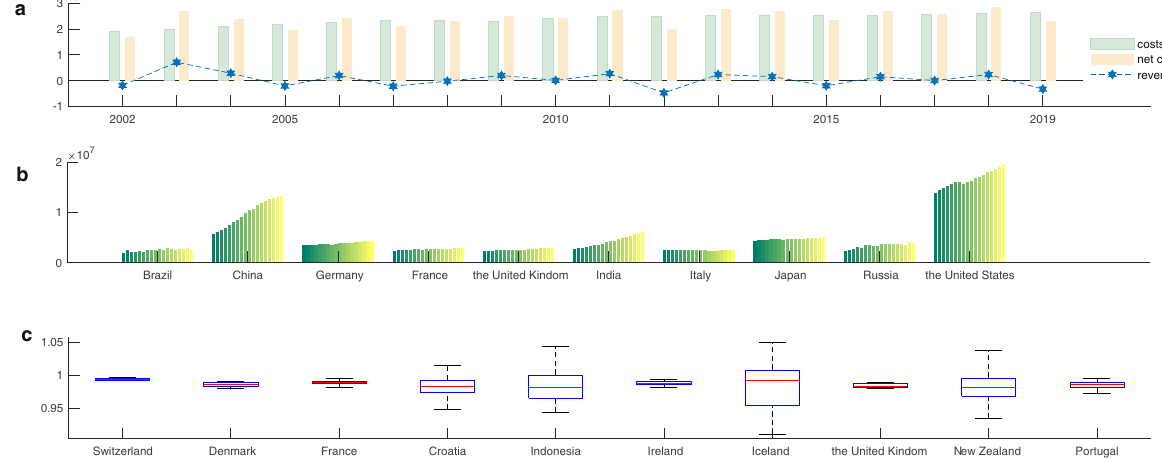
Fig. 4 Changes in the low-carbon economies from 2002 to 2019. a Revenues and costs and net costs of CO 2 emissions from 2002 to 2019. b Changes in the neo of top ten countries during 2002 – 2019. c Changes in the reo of top 10 countries during 2002 –